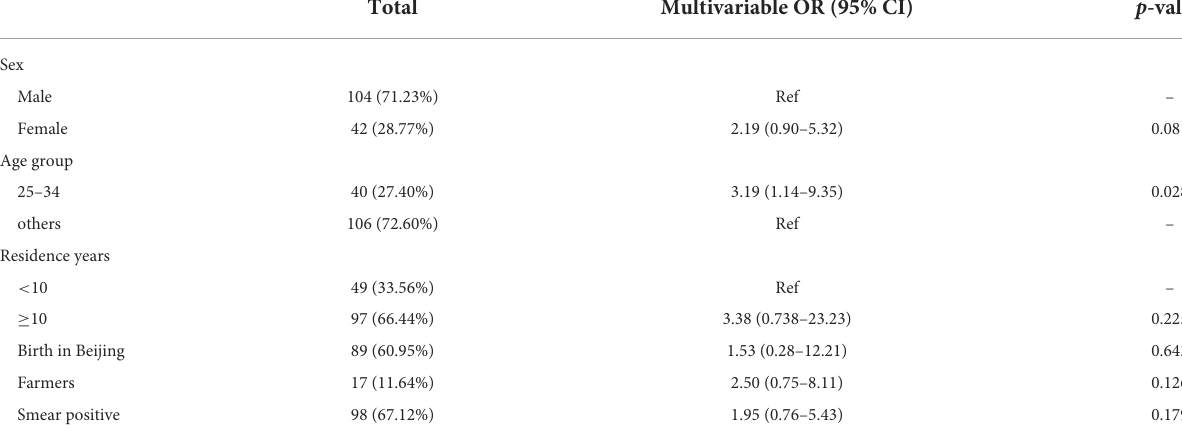
TABLE 2 Multivariable logistic regression on the risk factors of multidrug resistance